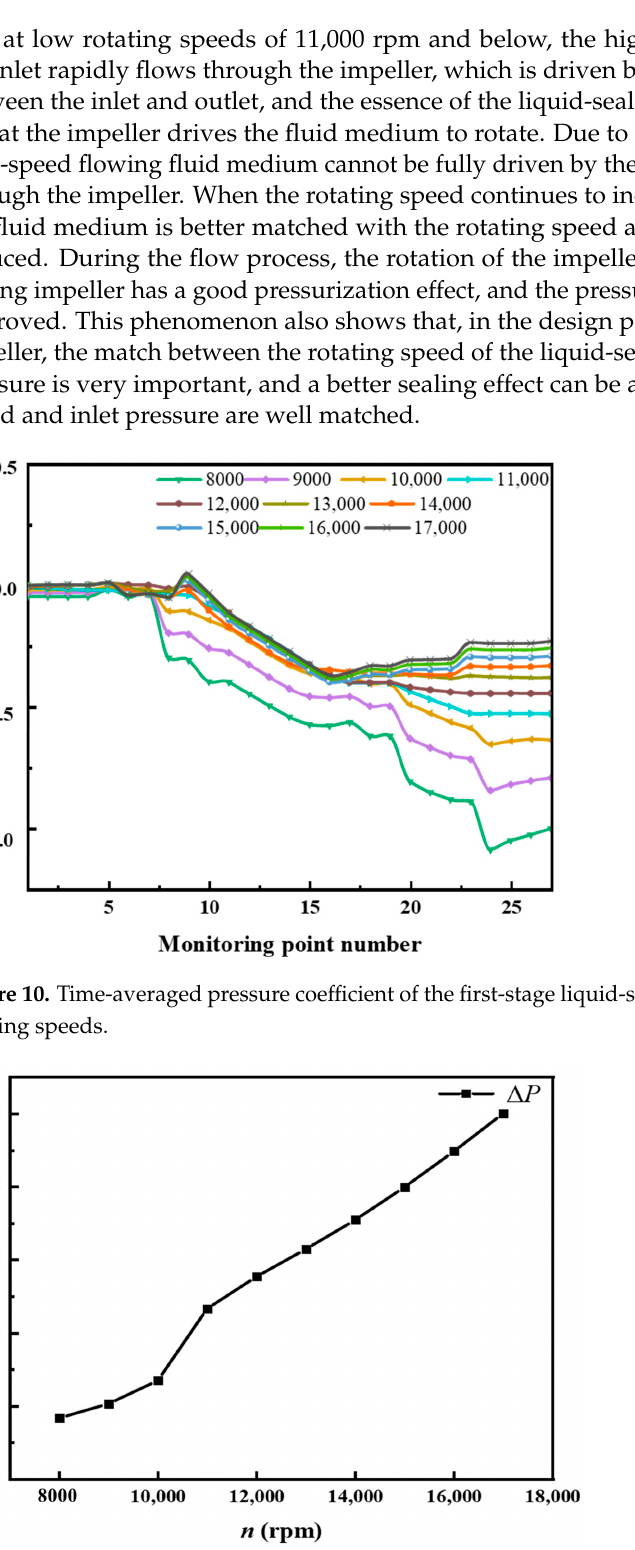
Figure 11. Pressurization value of the first-stage liquid-sealing impeller under different rotating speeds.